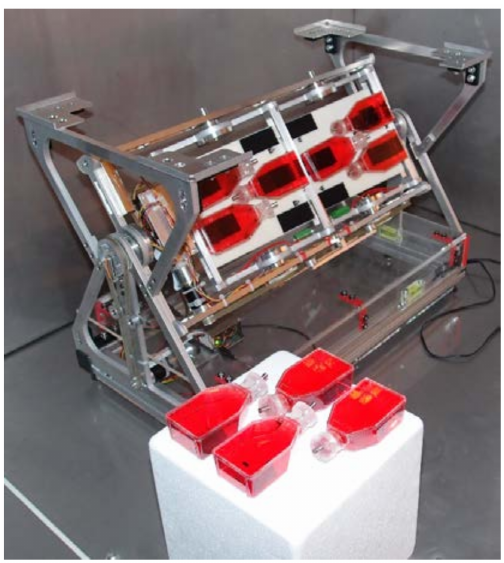
Figure 8. Random positioning machine (RPM). The RPM consists of a gimbal-mounted platform, which rotates samples continuously around two perpendicular axes. Samples were closed with a custom-made silicone plug and a stainless steel pin and subsequently fixed with Velcro onto the RPM. The Lucerne School of Engineering and Architecture developed the